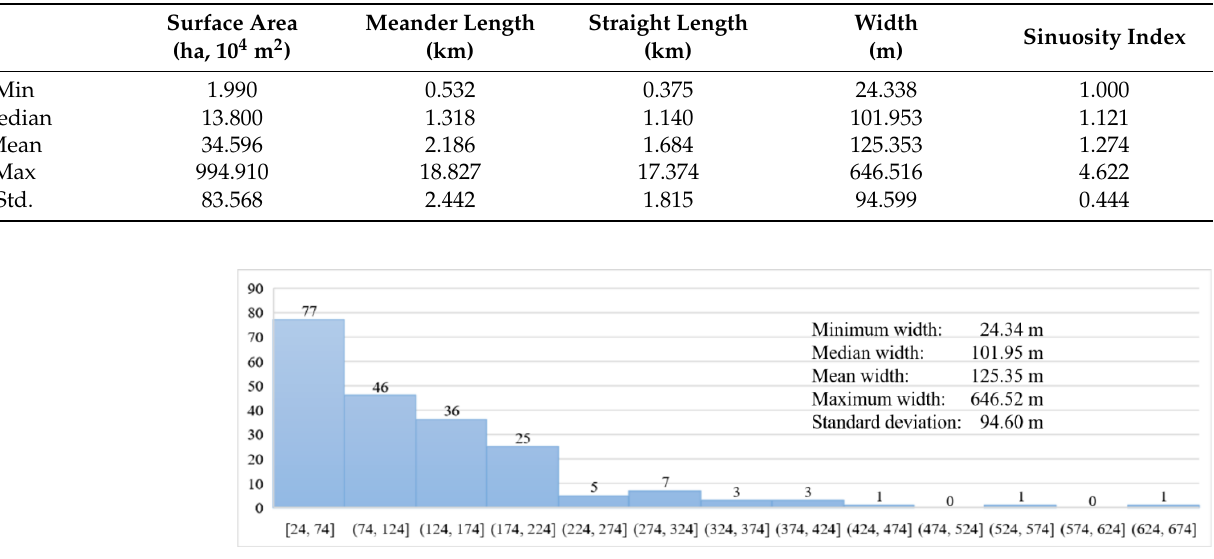
Table 5. The planform geometric attributes of delineated links.